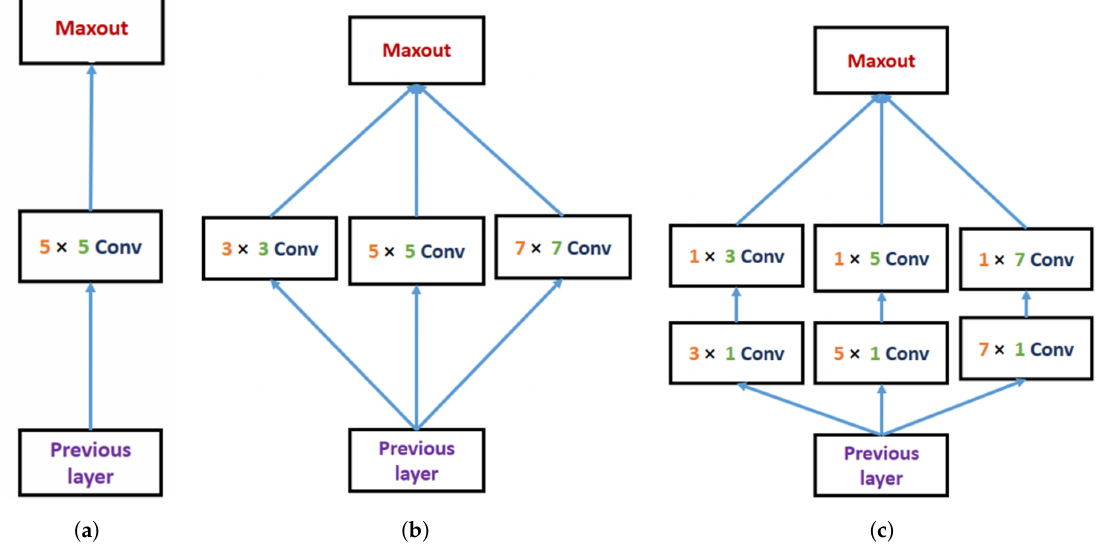
Figure 3. Proposed multi-scale inception block of two successive convolutions [53]. ( a ) Single Scale Convolution ( b ), Multi-Scale Convolution, and ( c )